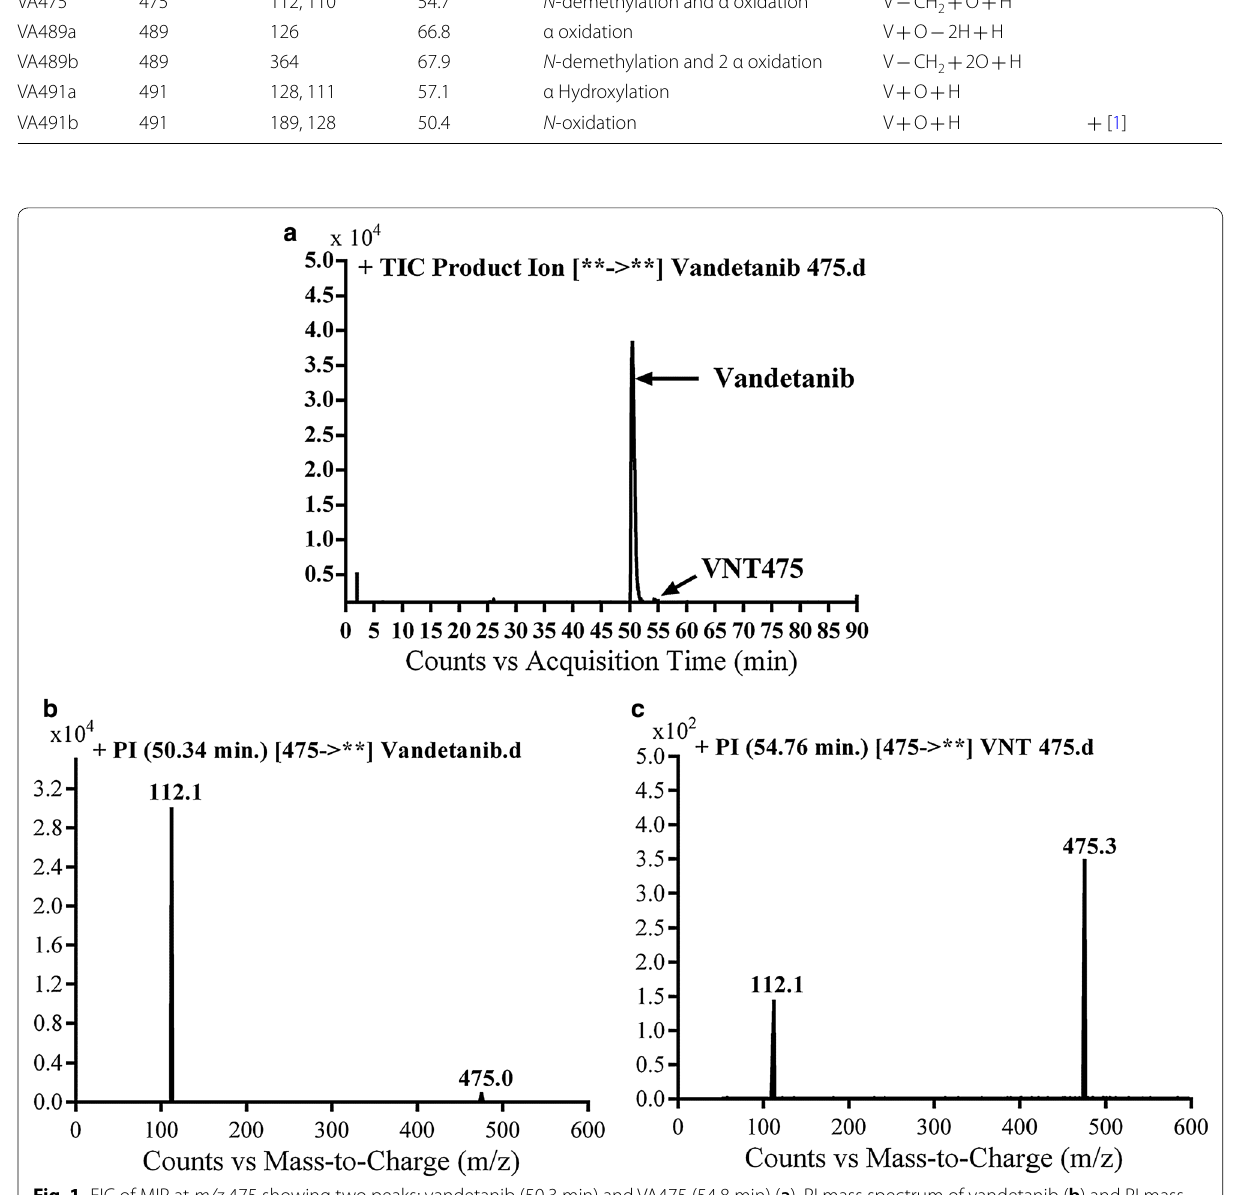
CID of VA475 MIP at m/z 475 gave daughters at m/z 112 and 110 in PI scan by QqQ MS (Fig. 1c). The frag- ment ion at m/z 112 proposed the removal of the methyl